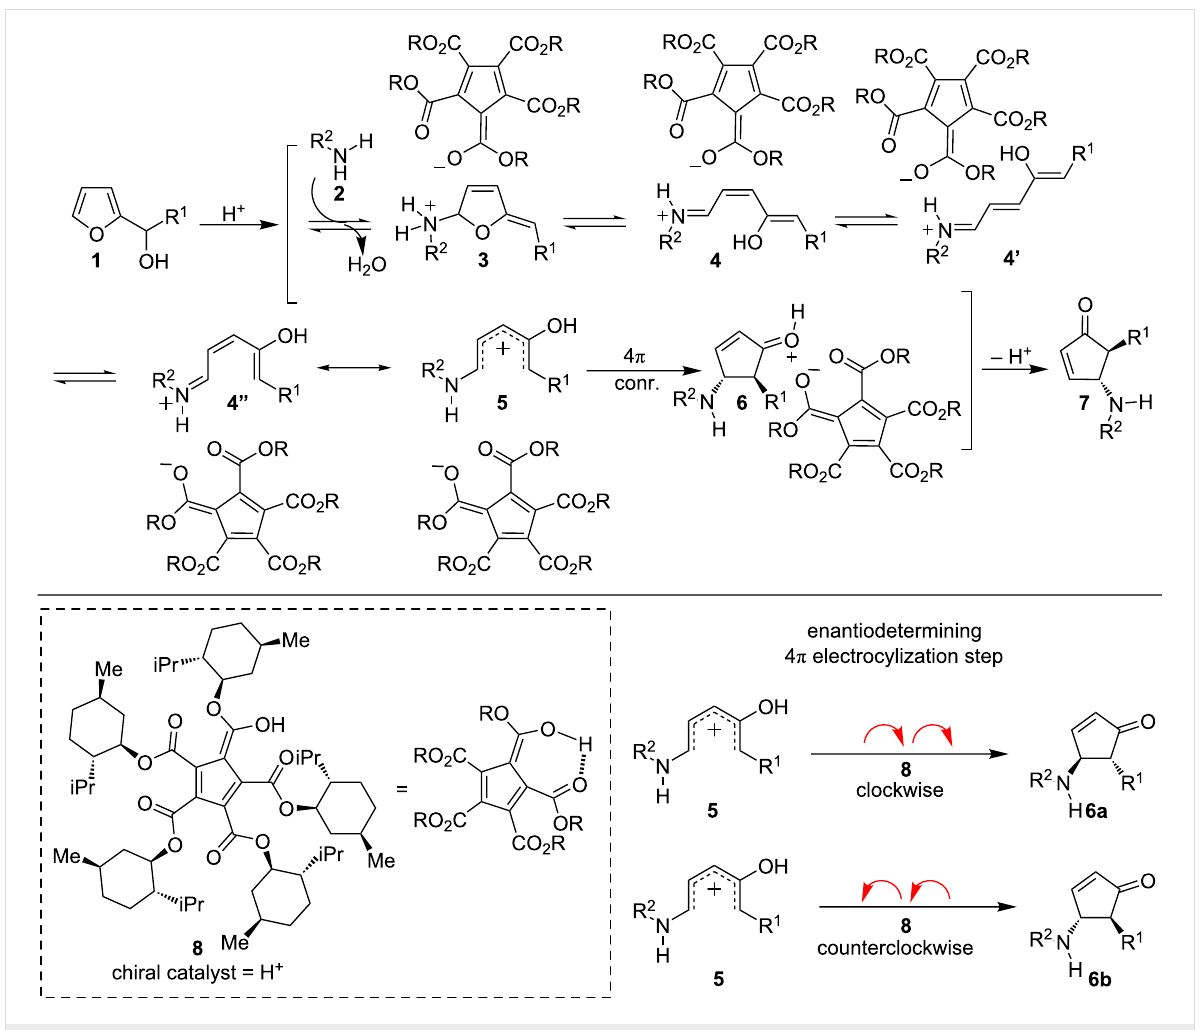
Figure 1: Proposed mechanism of the asymmetric aza-Piancatelli